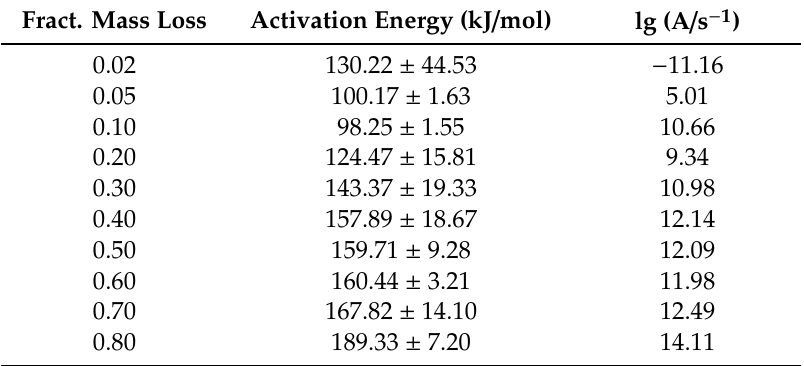
Table 1. Activation energy and pre-exponential coe ffi cient as a function of the degree of conversion by the Ozawa–Flynn–Walla method for a maize straw sample.